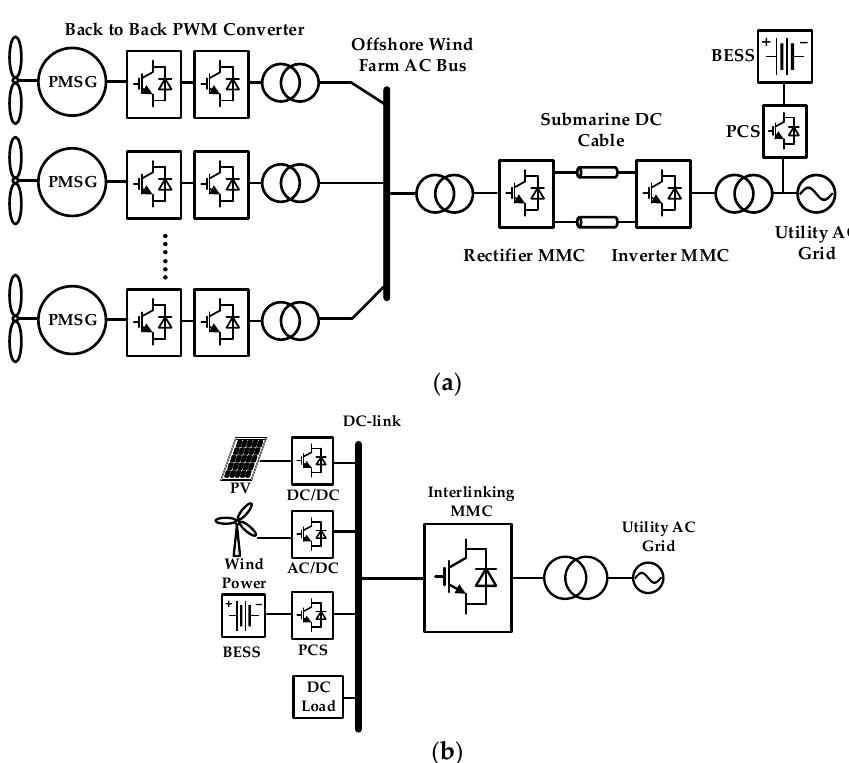
Figure 1. Applications of modular multilevel converter (MMC) topology with large-scaled renewable energy sources. ( a ) Offshore wind farm generation system based on two-terminal MMCs. ( b ) DC microgrid using MMC as interlinking converter.